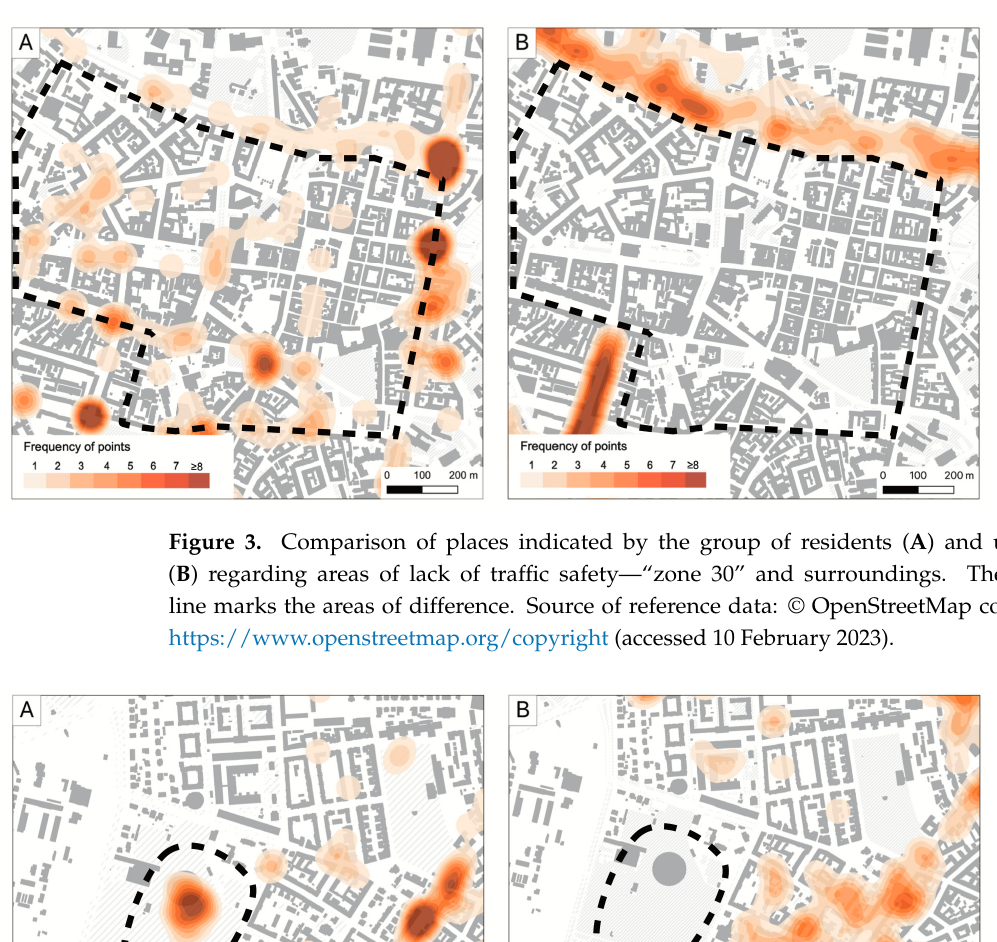
Figure 4. Comparison of places indicated by the group of residents ( A ) and urban planners ( B ) regarding areas of lack of thermal comfort—vicinity of Arena sports and entertainment hall. The dashed black line marks the areas of difference. Source of reference data: © OpenStreetMap contributors, see: https://www.openstreetmap.org/copyright (accessed 10 February 2023).